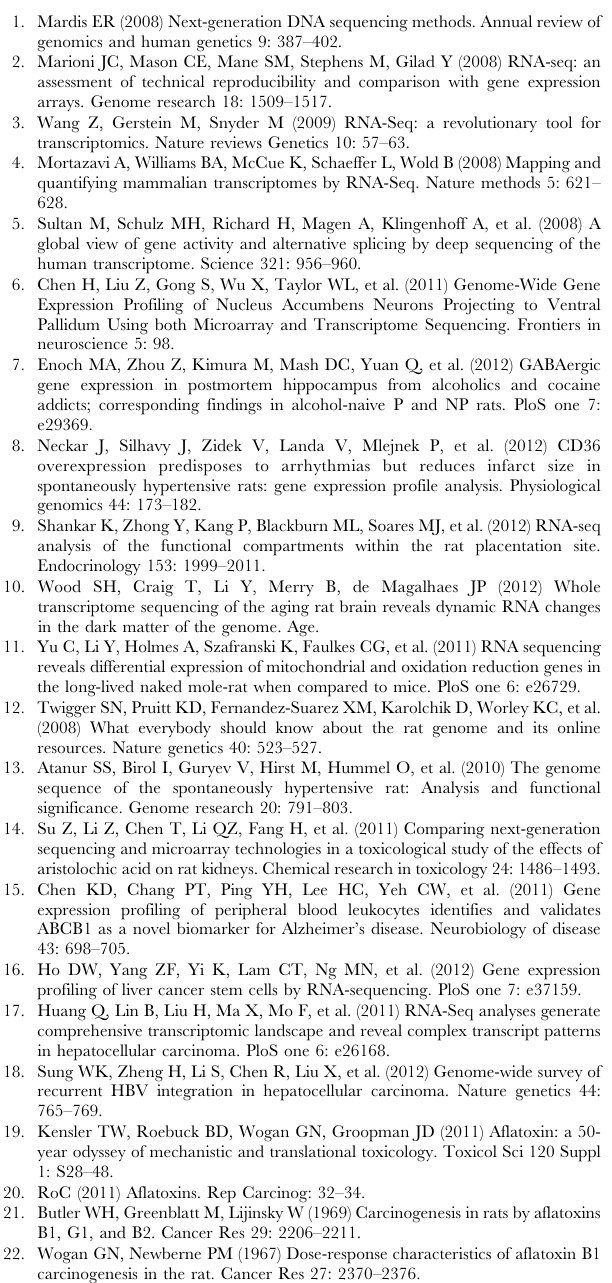
Table S6 Common canonical pathways of DESeq, Microarray, Cuffdiff analysis. Table S7 DESeq connectivity gene pathway. Table S8 Microarray connectivity pathway. (XLSX) Table S9 Cuffdiff connectivity pathway. (XLSX) Table S10 E2f1 connectivity pathway.